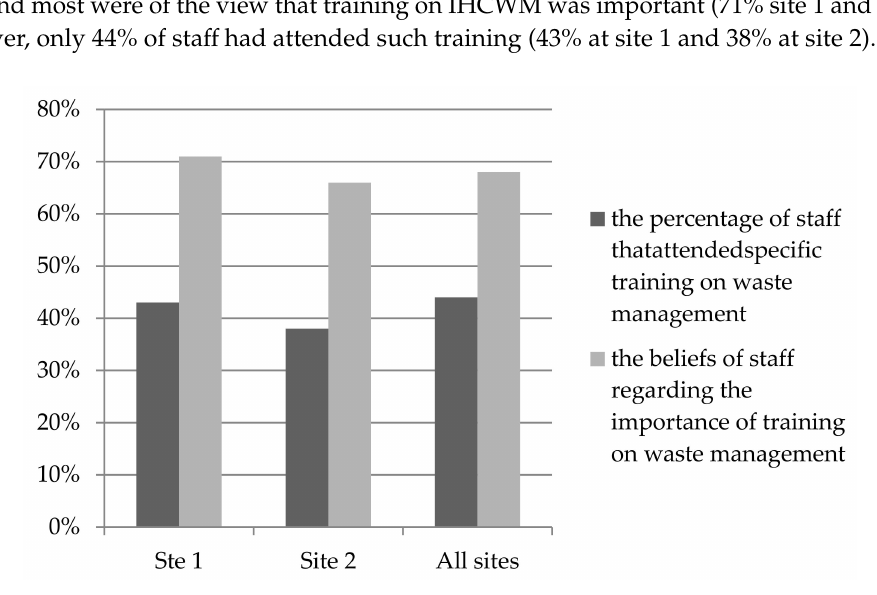
Figure 2. Beliefs regarding the importance of training and percentage of sta ff attendance at training.